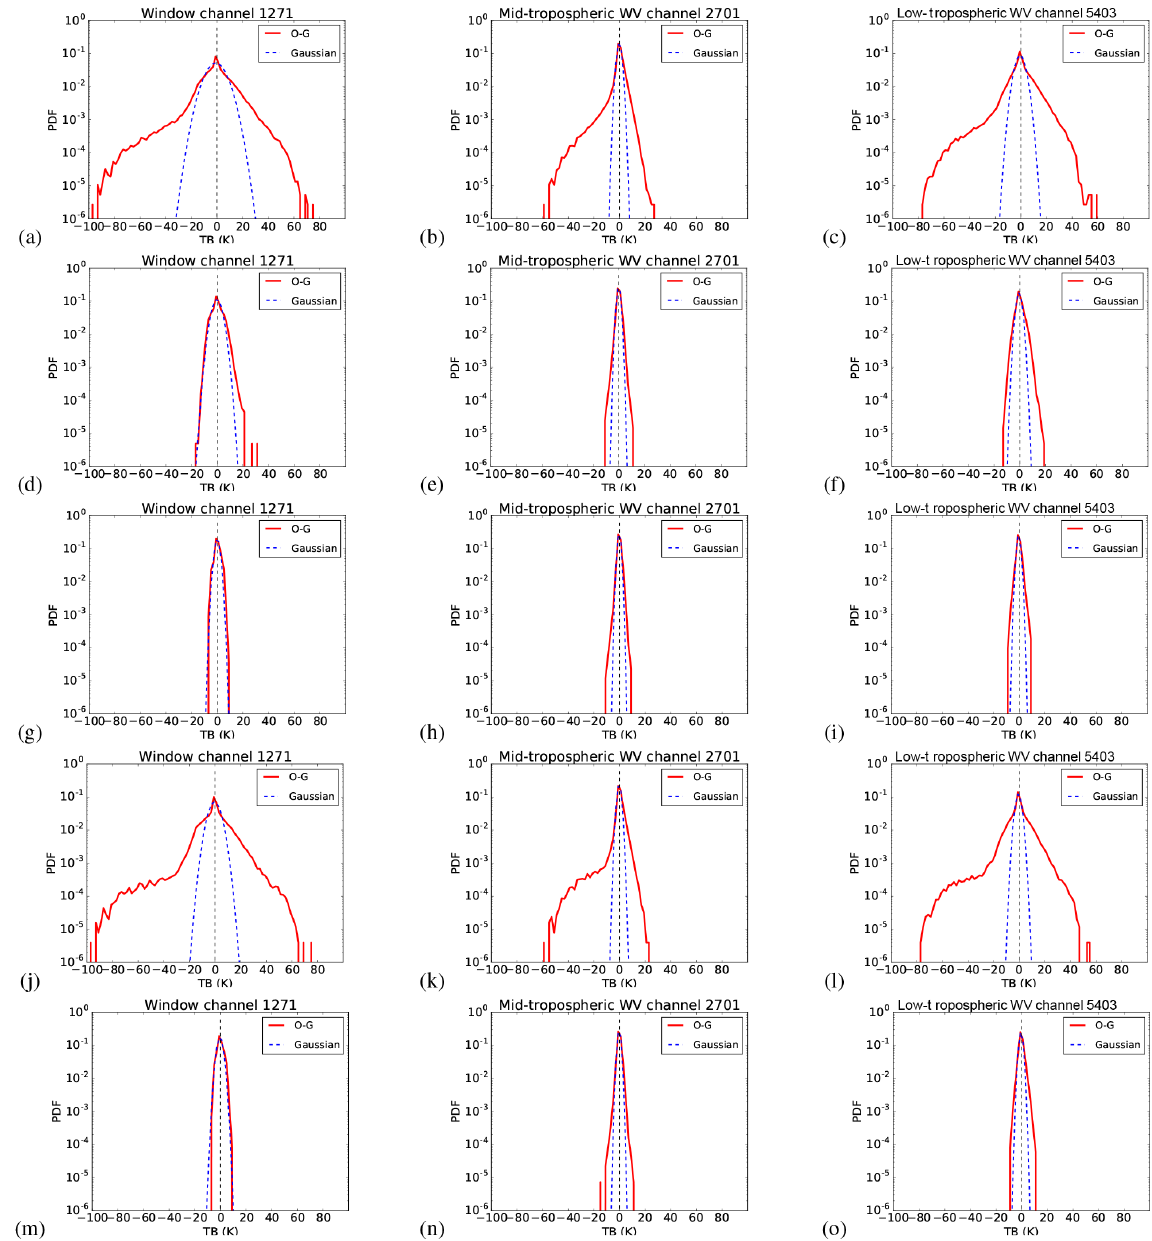
Figure 4. Frequency distribution of brightness temperature difference between observation and background (O − G) for all observations (a, b, c) , after applying the homogeneity criteria derived from Martinet et al. (2013) (d, e, f) , the homogeneity criteria derived from Eres- maa (2014) (g, h, i,) , the third method based on the observation space method (j, k, l) and the compromised approach (m, n, o) . The PDFs are presented for three channels: window channel 1271, low-tropospheric water vapour channel 5403 and mid-tropospheric water vapour channel 2701). The Gaussian distributions with the same error characteristics (mean and standard deviation) are also shown as blue dashed